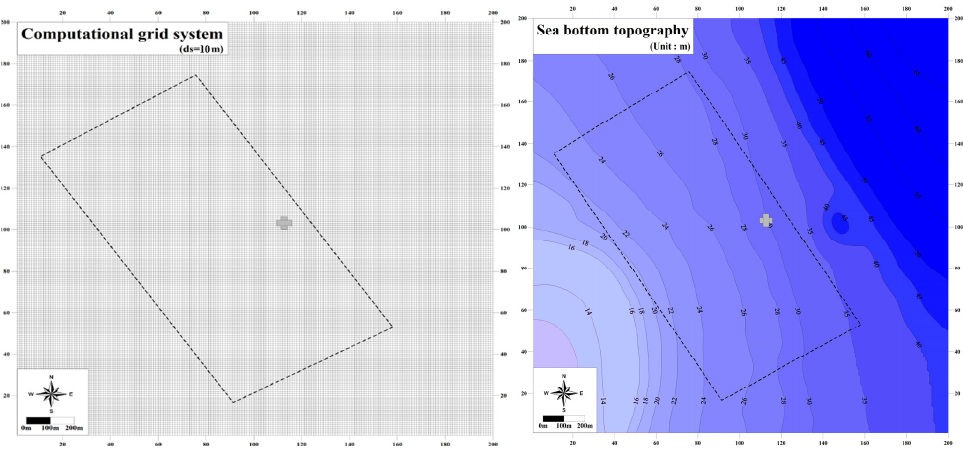
Figure 1. Computational grid and topography of the deployment location.